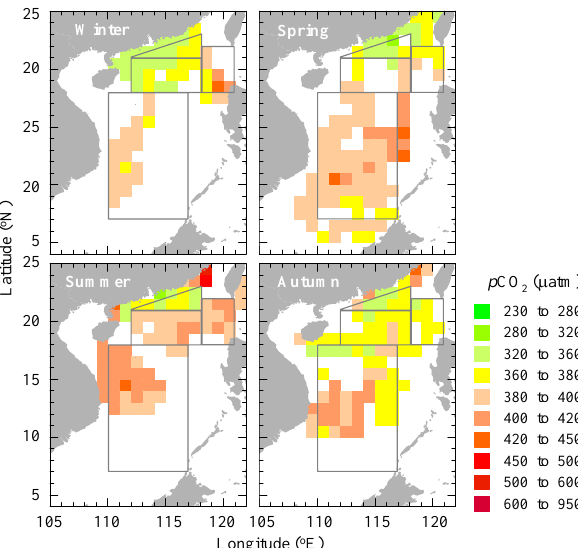
Fig. 6. Composite seasonal distributions of sea surface p CO 2 in the SCS proper during the period from October 2003 to April 2008 based on data presented in Fig. 2 and arithmetical averages over 1 ◦ × 1 ◦ grid boxes.